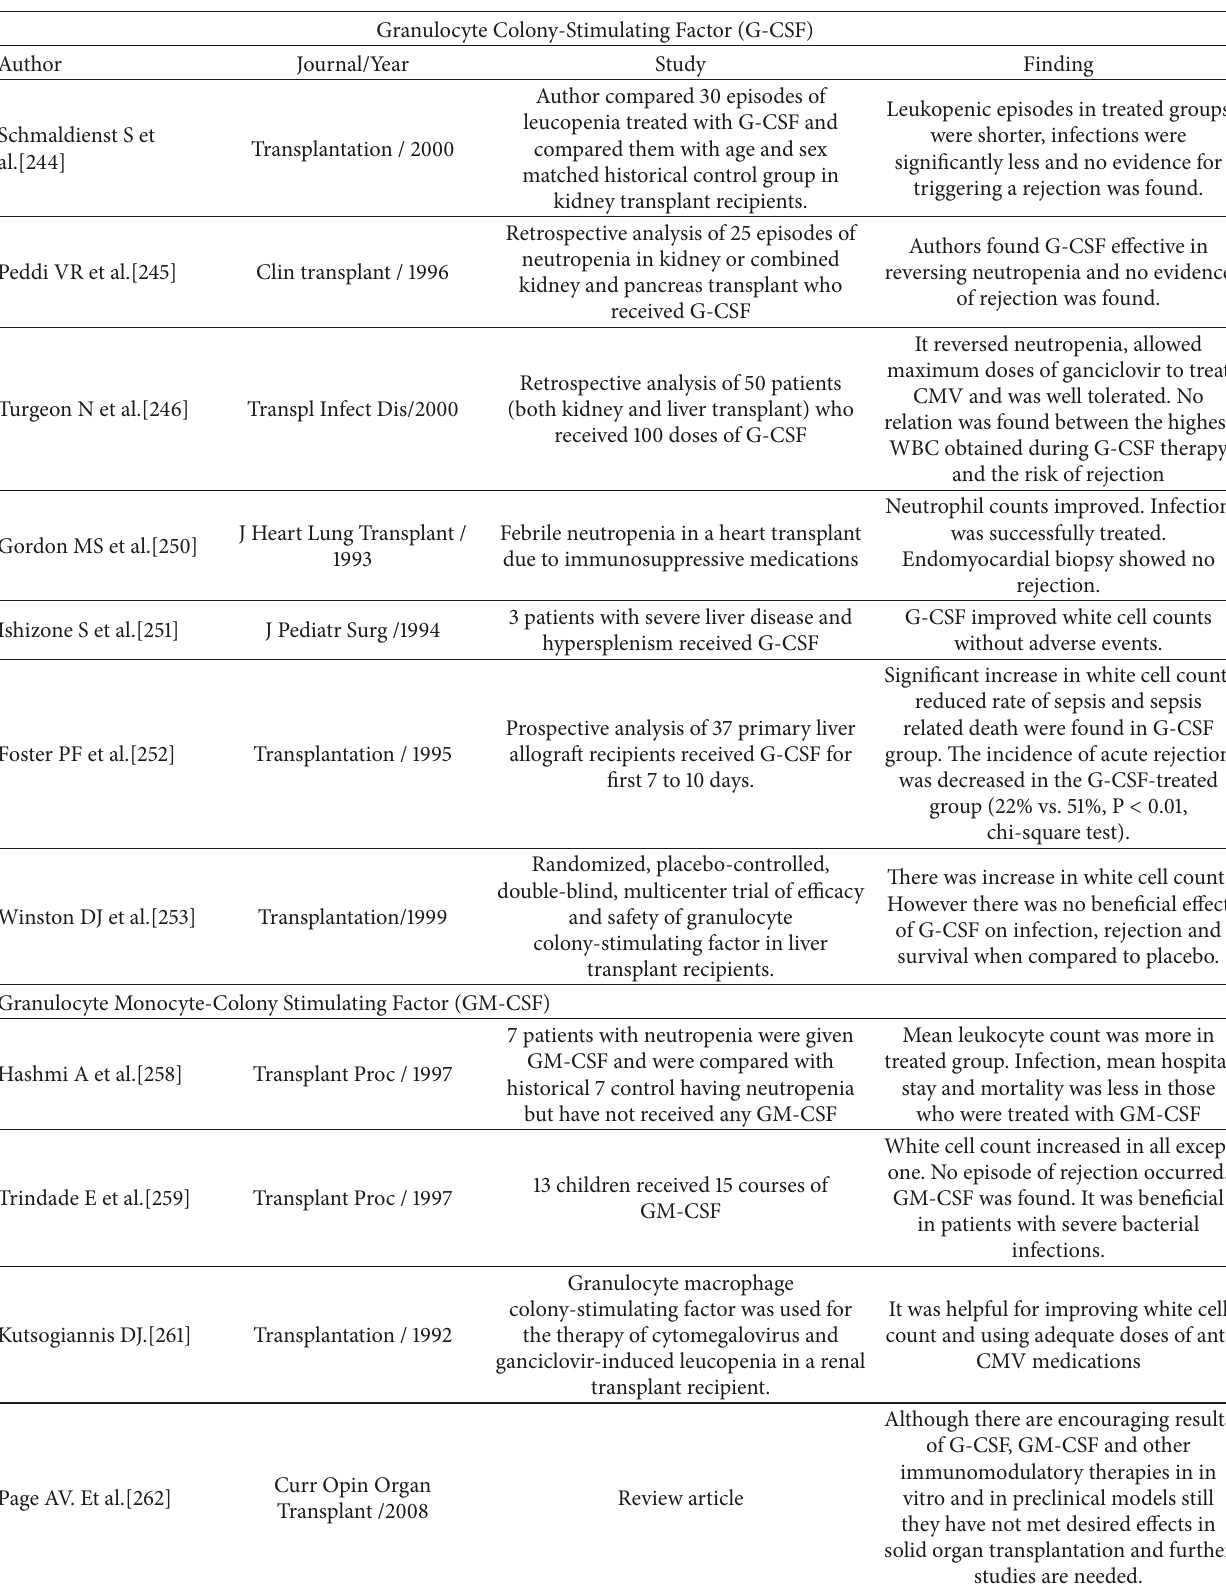
Table 2: Showing various studies done colony-stimulating